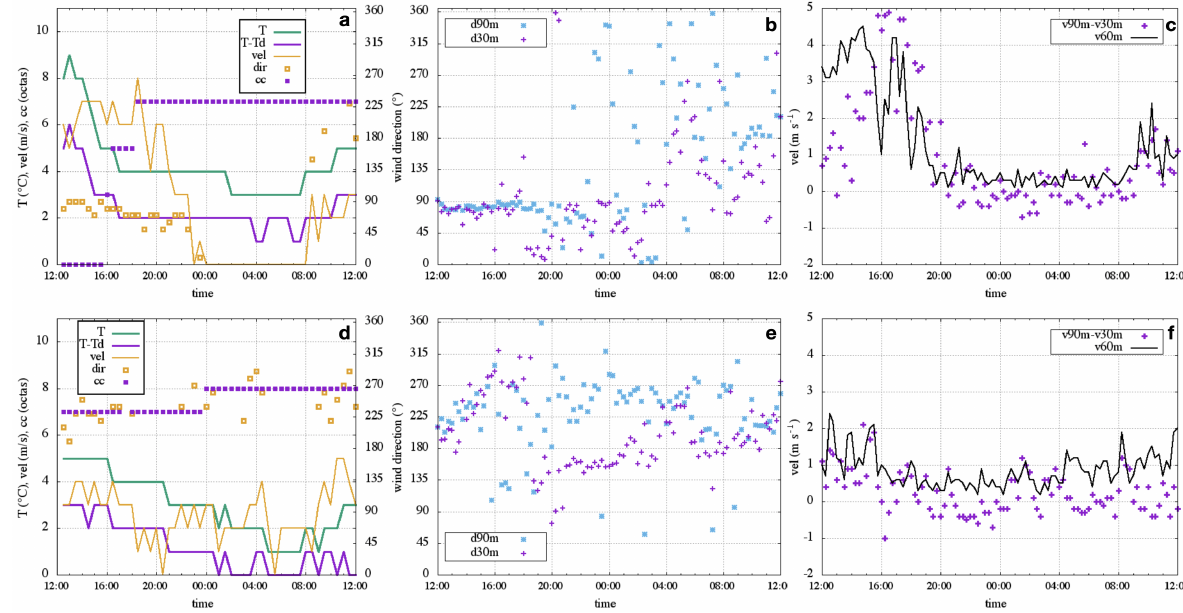
Figure 3. Sodar and METAR data at Zagreb Airport. For 27 to 28 January 2018: ( a ) half-hourly 24 h series of wind speed and direction at 10 m, T and dew point at 2 m, and cloud cover from Zagreb Airport METAR reports; ( b ) 15 min time series of wind direction at 10 m from METAR and 30 m and 90 m from sodar; ( c ) sodar wind speed at 60 m and speed difference between 90 and 30 m. In the lower row, the same figures ( d – f ) are shown for 28 to 29 January